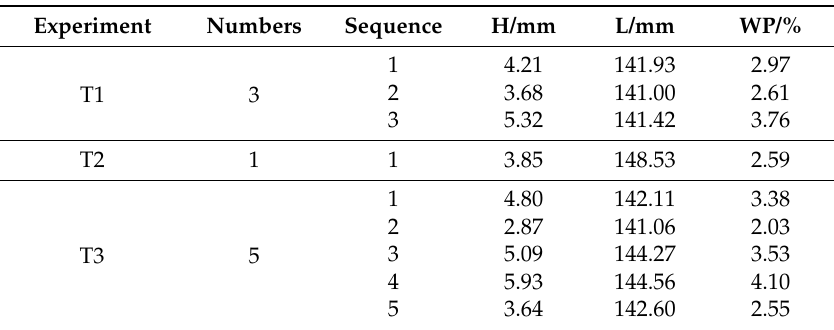
Table 3. Drying defects statistics for T1, T2, and T3.